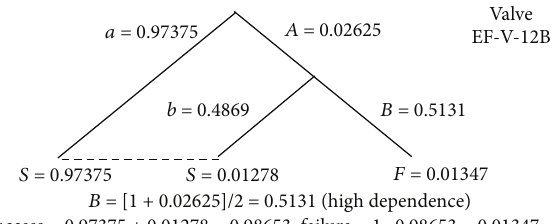
Figure 4: Dependence between teams that operate EF-V-12A and EF-V-12B